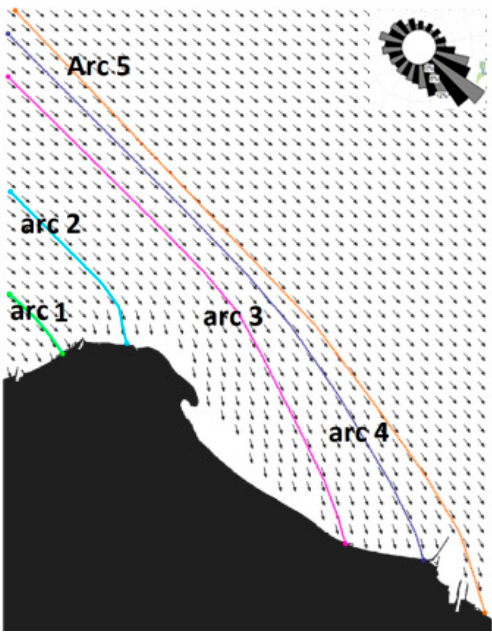
Figure 2. Average wave direction o ff Damietta Port Said coast, these five arcs from 1 to 5 are perpendicular to the wave crest and ordered southwards to simulate the changes in wave height moving from deep water towards the land. They range is between 1.56 and 2.06 for the study area.